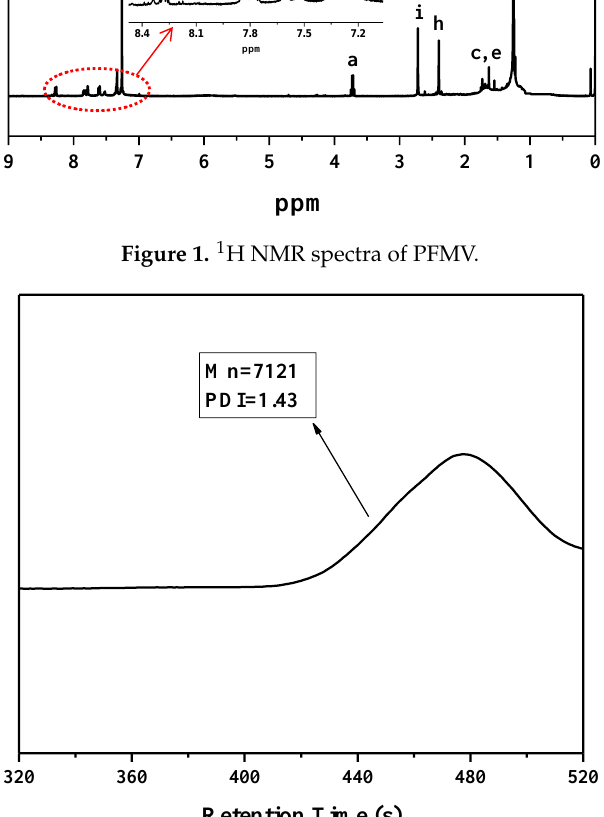
Figure 2. GPC spectra of PFMV.